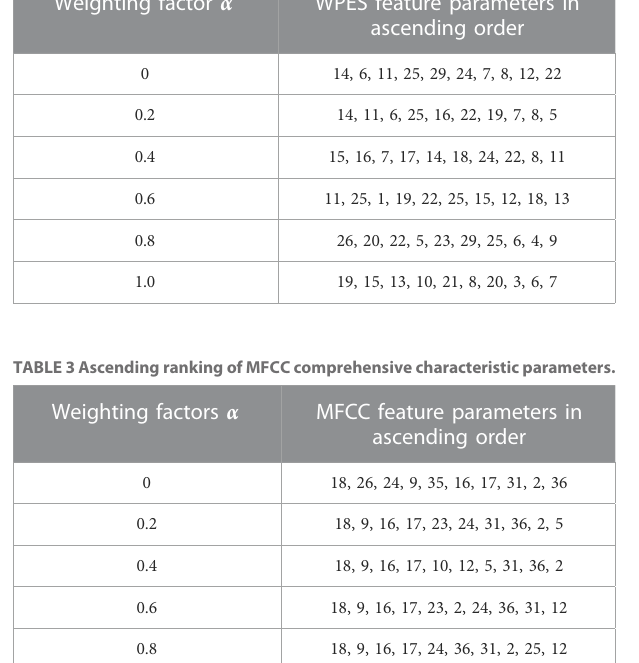
TABLE 2 The ascending order of WPES comprehensive characteristic parameters. Weighting factor α WPES feature parameters in ascending order